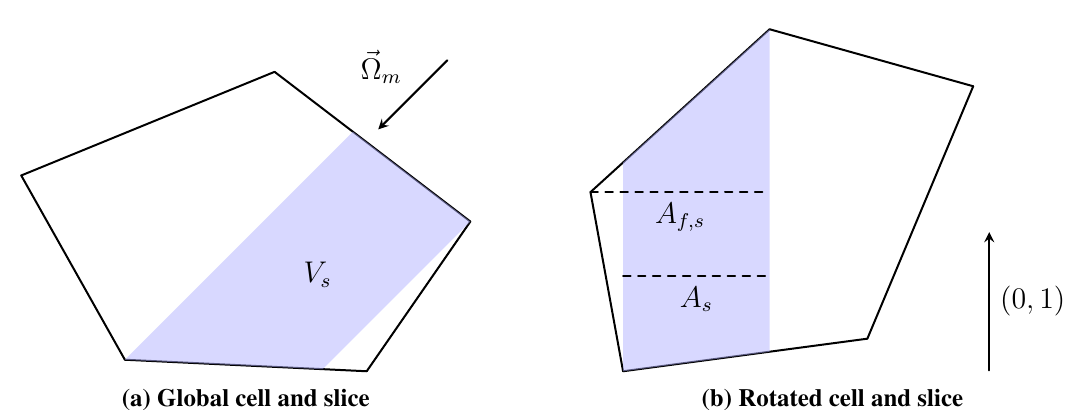
Figure 2: Demonstrative polygonal cell and singular slice (left) which is then rotated so that the angle aligns with (0 , 1)